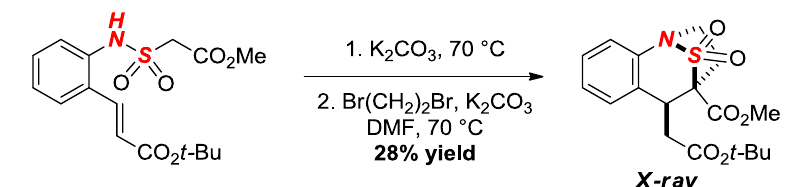
Figure 18. Synthesis of an Apex Bridged Sultam via 1,4-Addition.